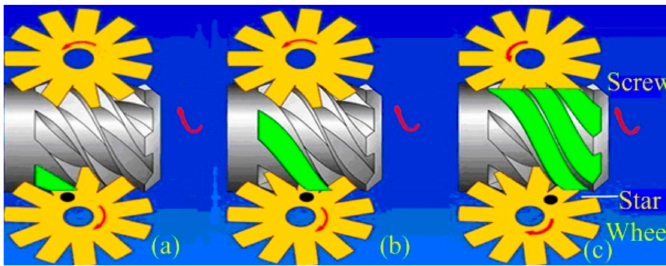
Figure 2. Working processes of single-screw expanders: ( a ) suction, ( b ) expansion, and ( c )